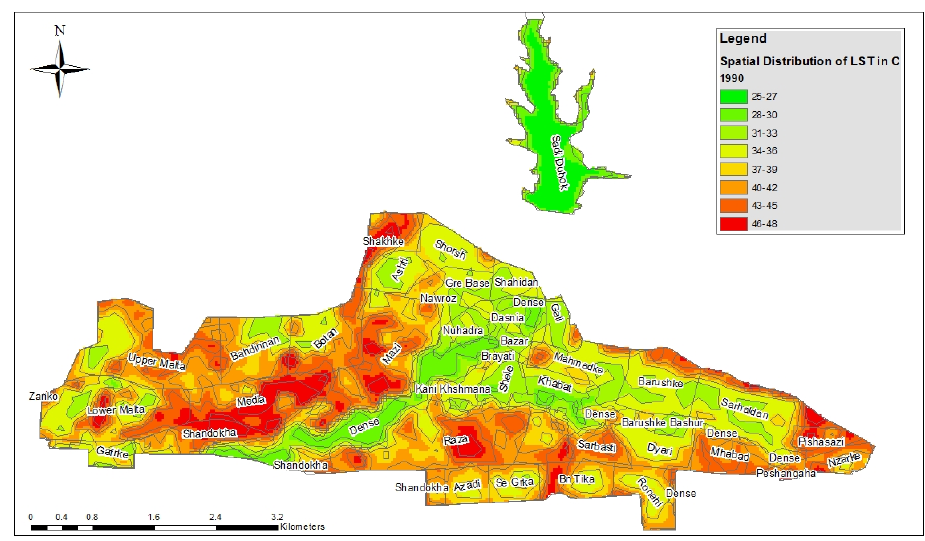
Figure 5. Spatial distribution of land surface temperature (LST) for 1990.